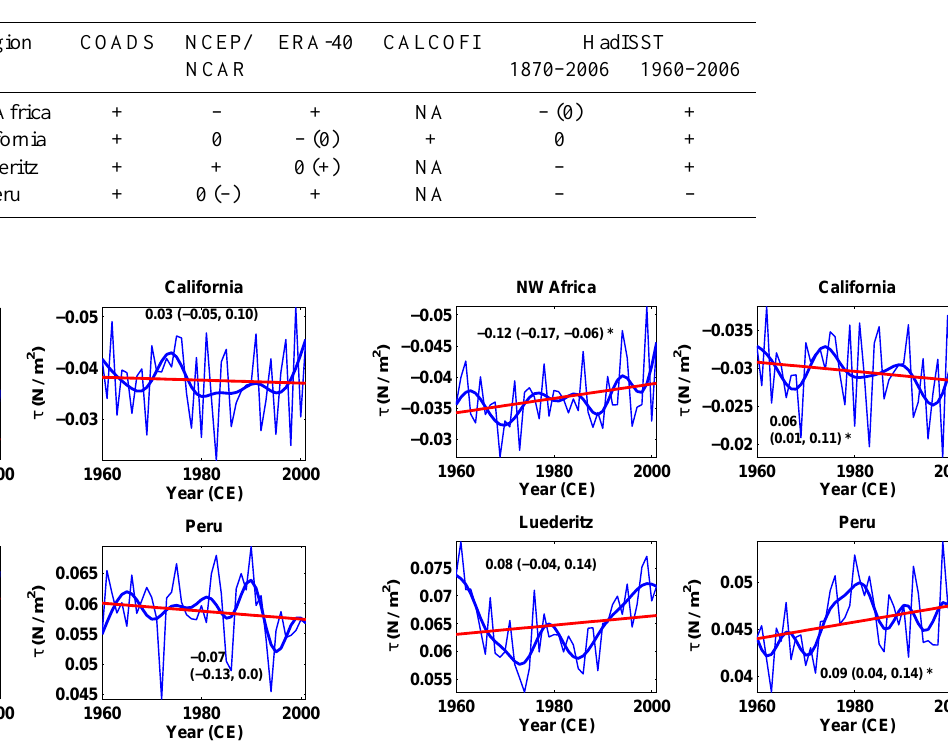
Fig. 5. Linear trends (red line) of meridional wind stress from the ERA-40 dataset (Uppala et al., 2005) estimated by the method of least squares. NW Africa and Peru show an increase of up- welling. There is a decrease of upwelling in California and in- significant trend in L¨uderitz. In the Northern Hemisphere a neg- ative slope indicates increase of upwelling.The value of the slope and its 95% confidence interval are given in each panel (in units of 10 − 3 Nm − 2 yr − 1 ). A ∗ indicates that the slope is statistically significant at the 0.05 level. Also shown are the unsmoothed time series (thin